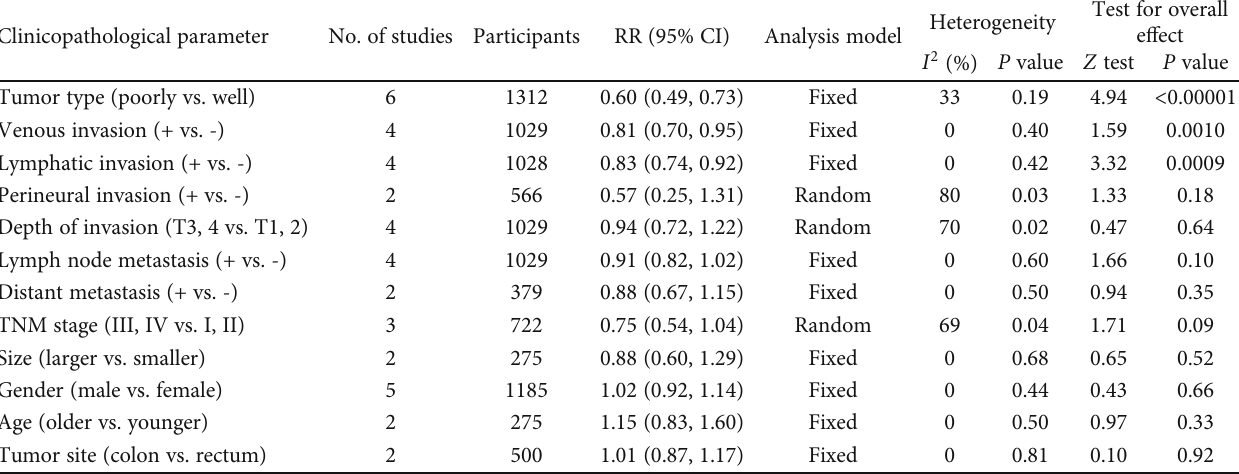
Test for overall Heterogeneity e ff ect I 2 (%) P value Z